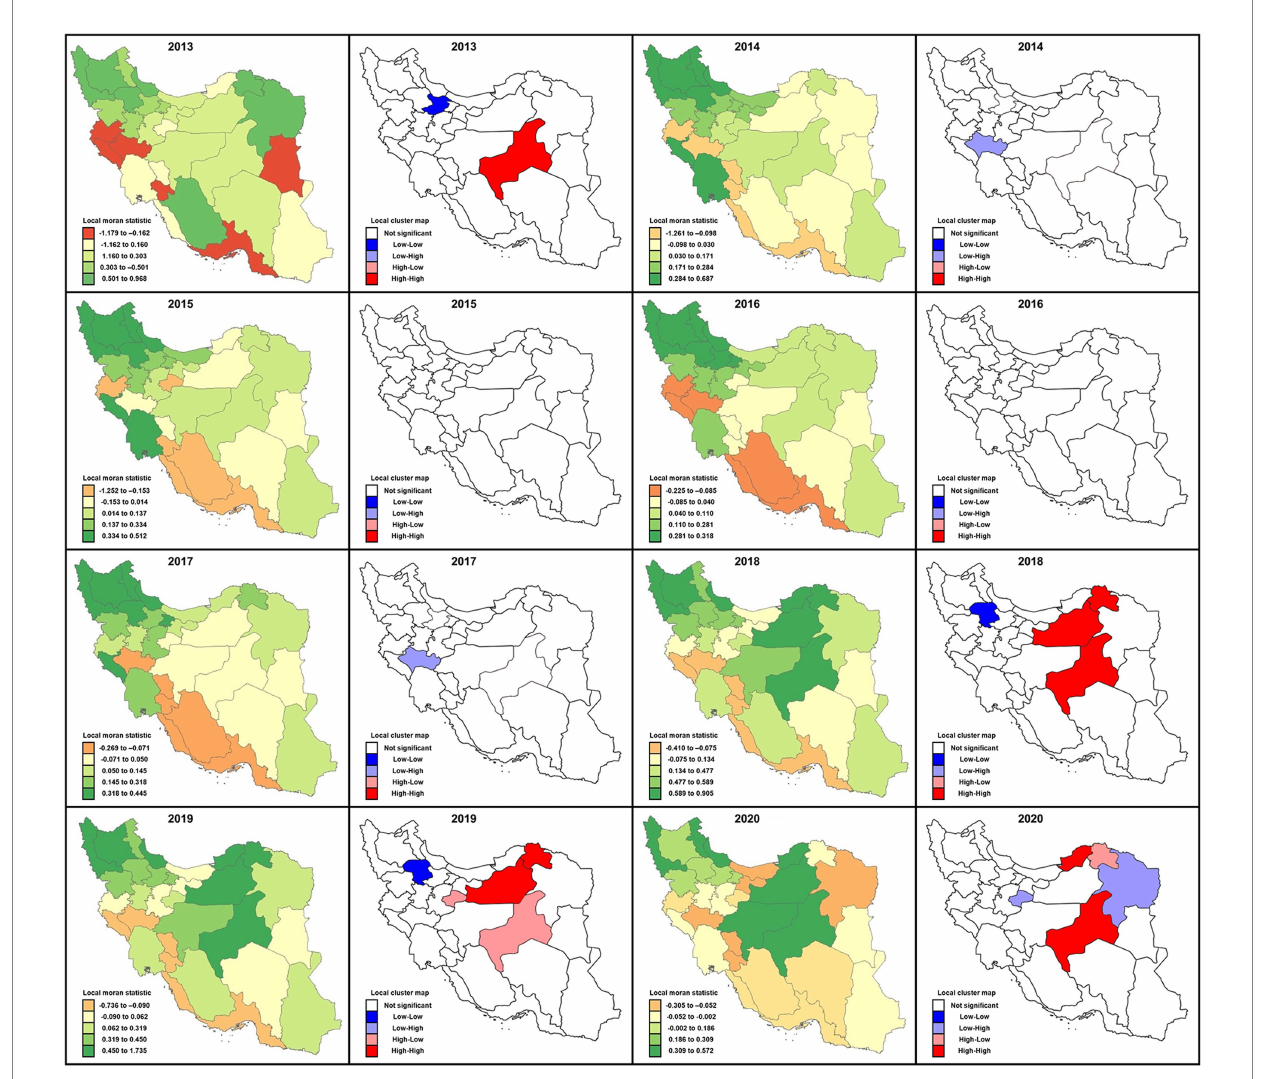
FIGURE 5 Local Moran’s I statistics and local cluster map for spatial autocorrelations illustrating clustering locations of cutaneous leishmaniasis distribution in different provinces of Iran, 2013–2020. Moran’s value has been mapped to highlight the incidence rates according to relative importance and surrounding neighbors’ behavioral relationships possessing four different categories: high-high, low-low, low-high, and